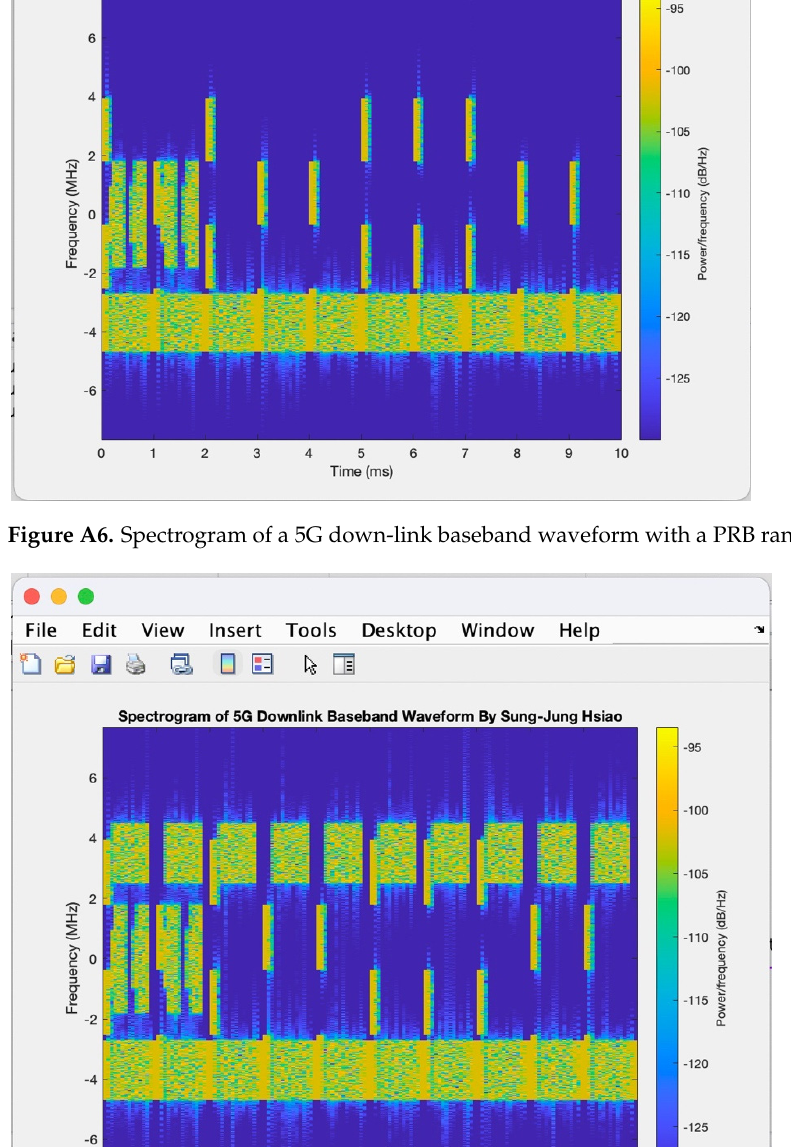
Figure A7. PRB values 40 to 50 and OFDM symbols 2 to 10.